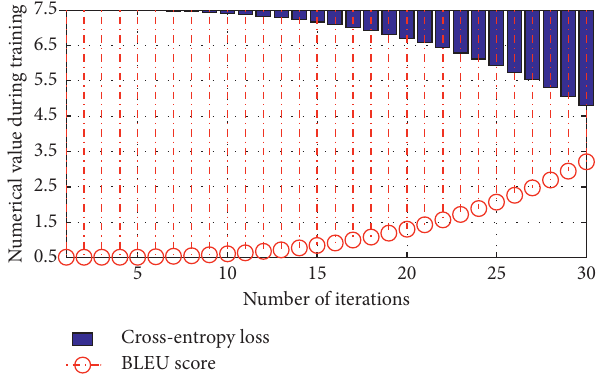
Figure 11: Cross-entropy loss and BLEU score during model